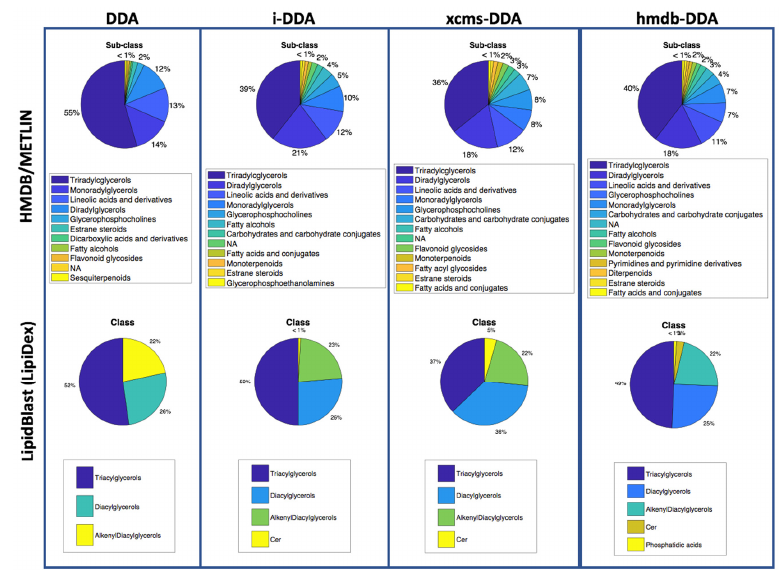
Figure 5. Distribution of the classes of metabolites annotated using the HMDB/METLIN or LipidBlast spectral libraries and spectra acquired by DDA, i-DDA, xcms-DDA or hmdb-DDA.